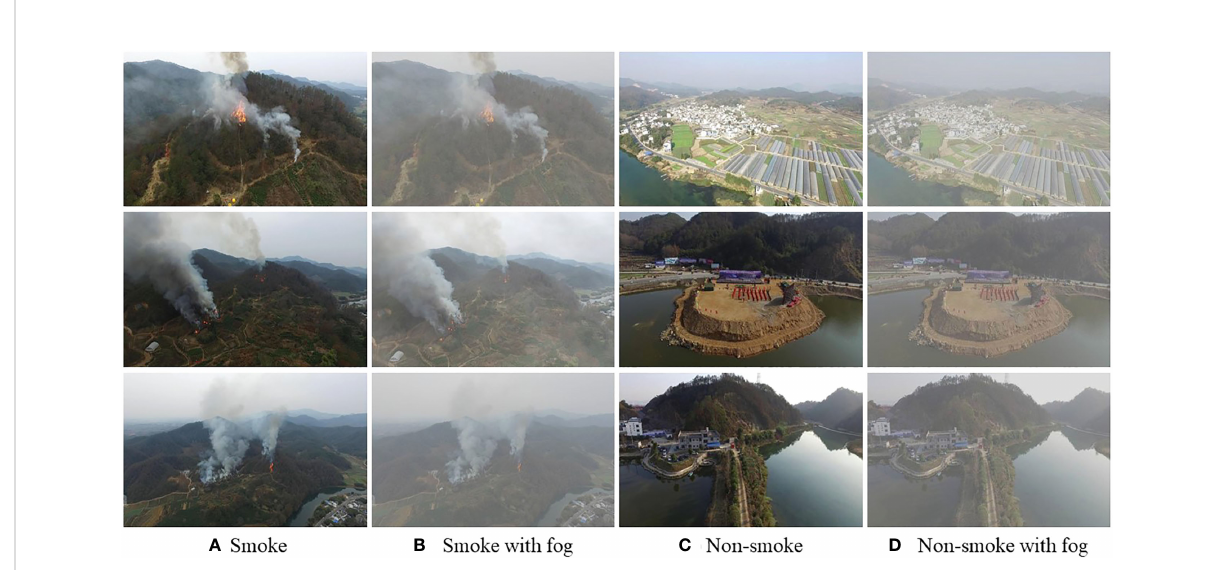
FIGURE 5 Representative images of smoke, smoke with fog, non-smoke, non-smoke with